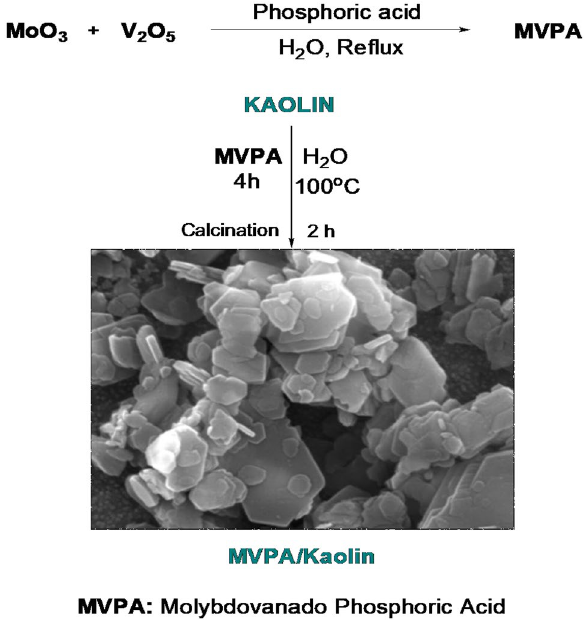
Fig. 1 Schematic diagram for synthesis of molybdovanado phos- phoric acid/kaolin